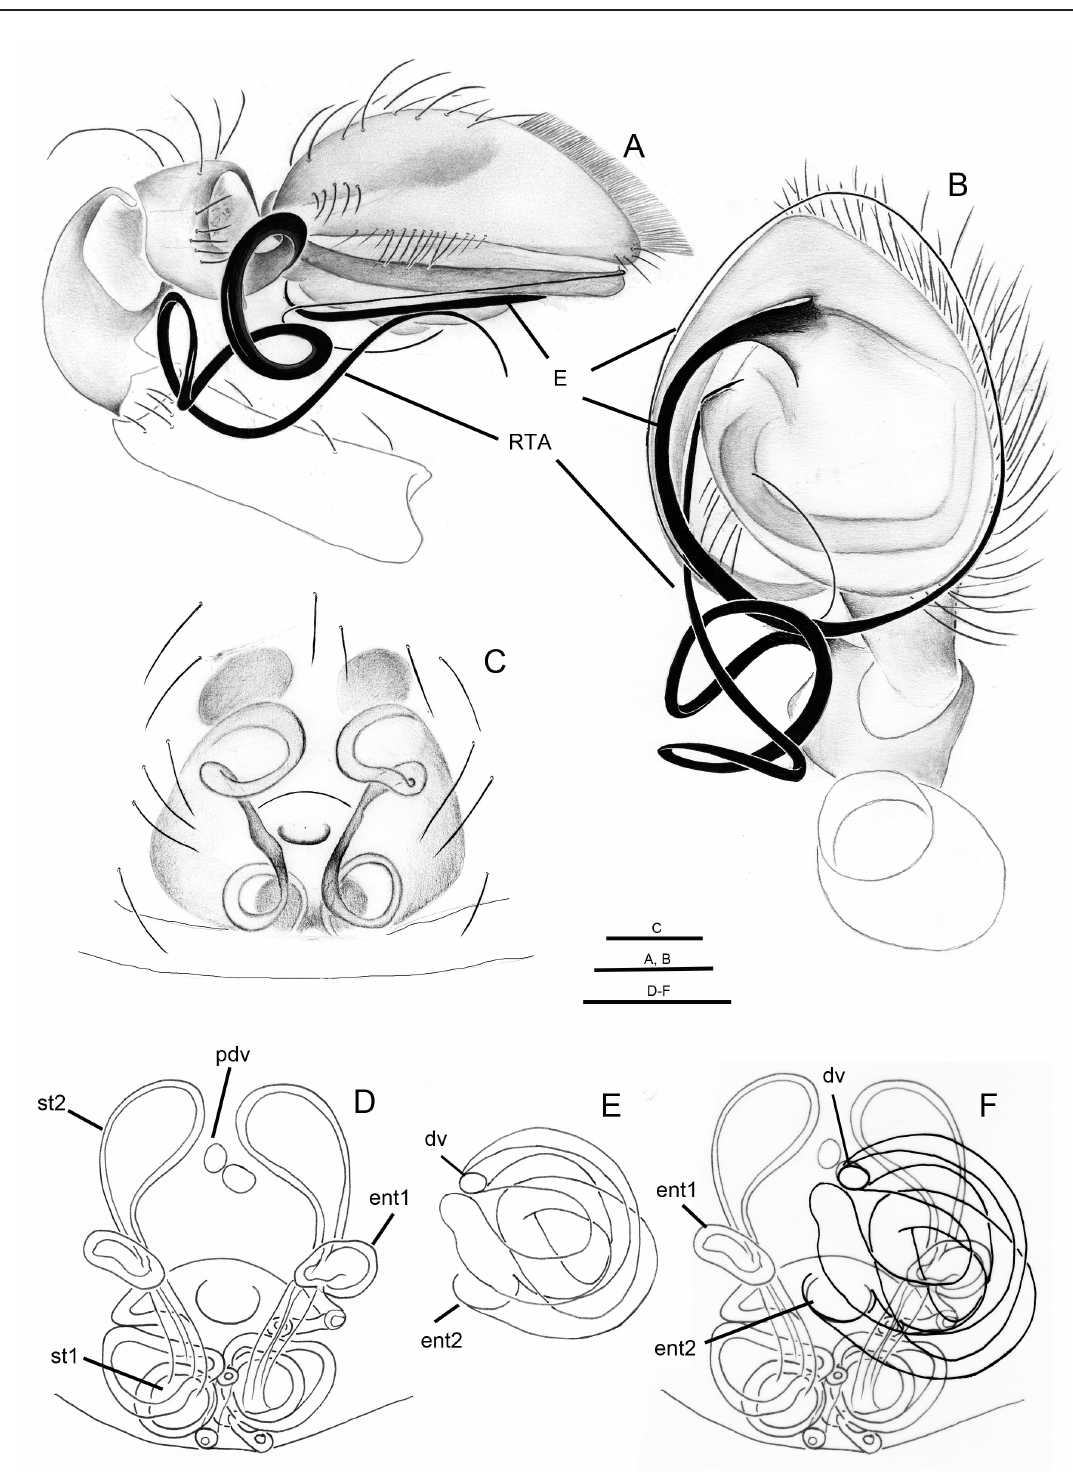
Fig. 2. Hortipes gigapophysalis sp. nov. A . Male palp, lateral view. B . idem, ventral view. C . epigyne, ventral view. D . epigyne, cleared, dorsal view, second system omitted. E . idem, primary system omitted. F . idem, both systems combined. e: embolus, ent1: entrance of insemination duct, ent2: entrance of secondary duct system, dv: dorso-ventral stretch of secondary duct system, pdv: position of dorso- ventral stretch, RTa: retrolateral tibial apophysis, st1: spermathecae 1, st2: spermatheca 2. scale bars: